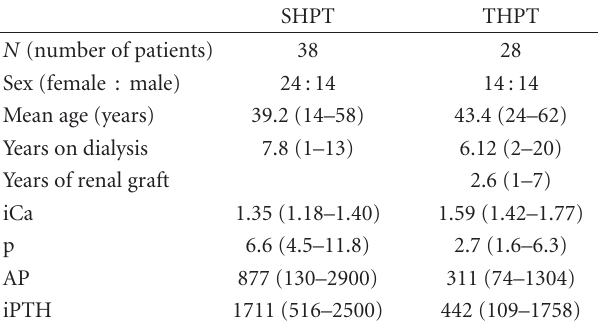
Table 1: Characteristics of patients and preoperative laboratory